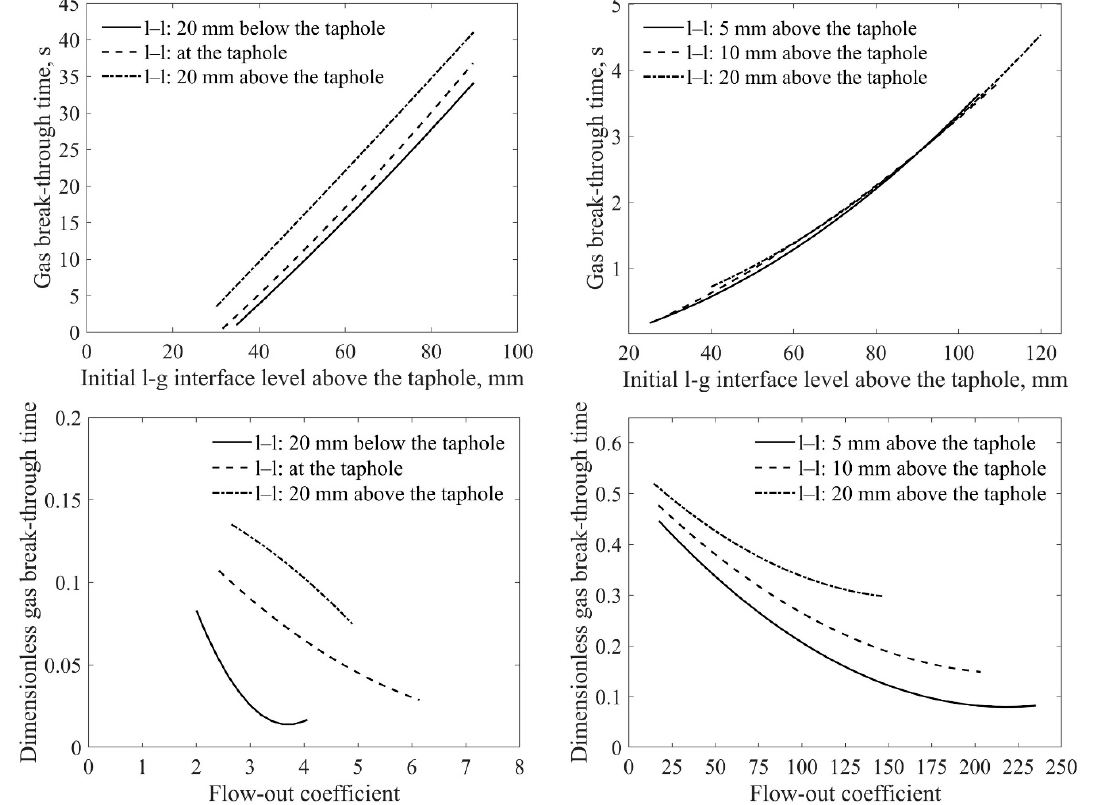
Figure 16. Comparison of some results from He et al. [9] (left panels) with results of the present work (right panels). Top: Effect of initial l–g interface on gas breakthrough time. Bottom: Effect of flow-out coefficient on dimensionless gas breakthrough time.